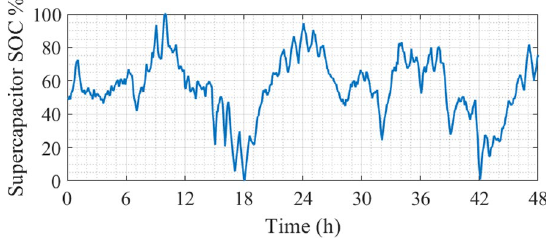
Fig. 7 SOC of supercapacitor during dispatch